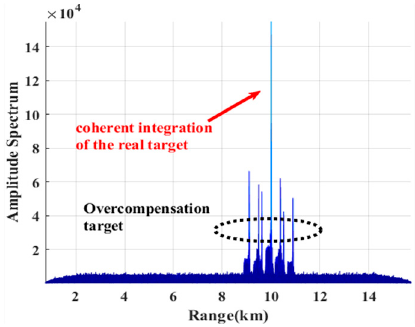
Figure 15. Range–axis projection of coherent integration result after compensating based on the improved Keystone algorithm.